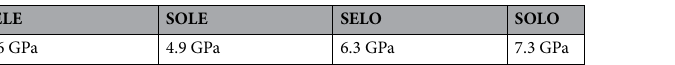
Table 2. Compressive pressure points (see Fig. 2) for first significant volume drop for sI methane hydrates with four different occupancies (SELE, SOLE, SELO and SOLO).